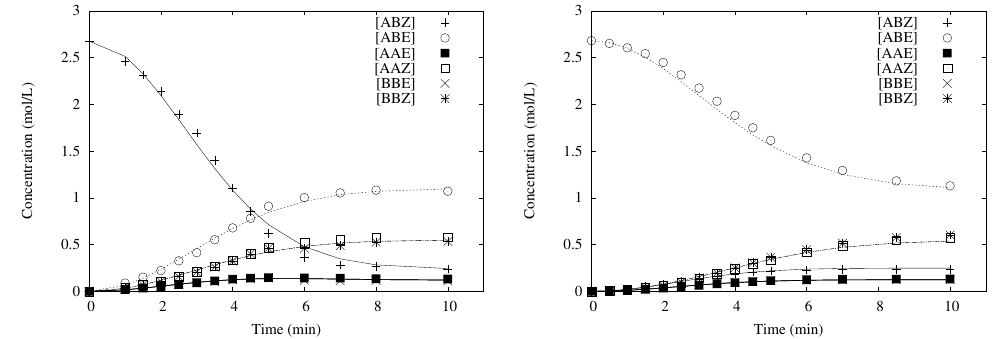
Figure 6. Computed and experimental concentration profiles for M71-SIPr pre-catalyst at 40 ◦ C, [Ru] = 1.4 × 10 − 5 mol/L, [AB] = 2.7 mol/L: (Left) starting from the Z -isomer; and (Right) starting from the E -isomer. Lines represent the modeled concentrations (discrete values connected with straight